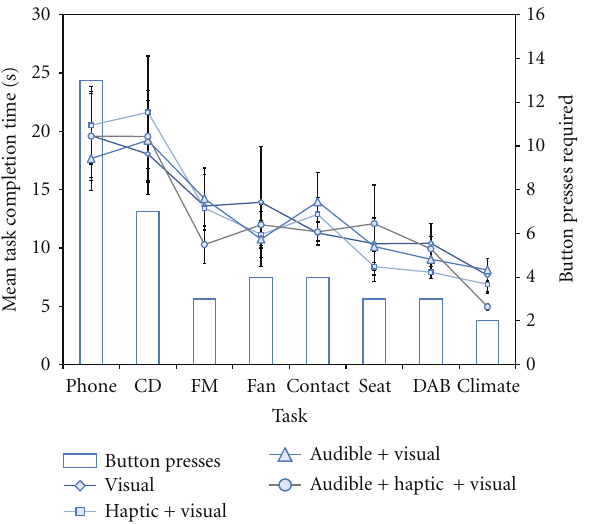
Figure 9: Touchscreen task completion time.